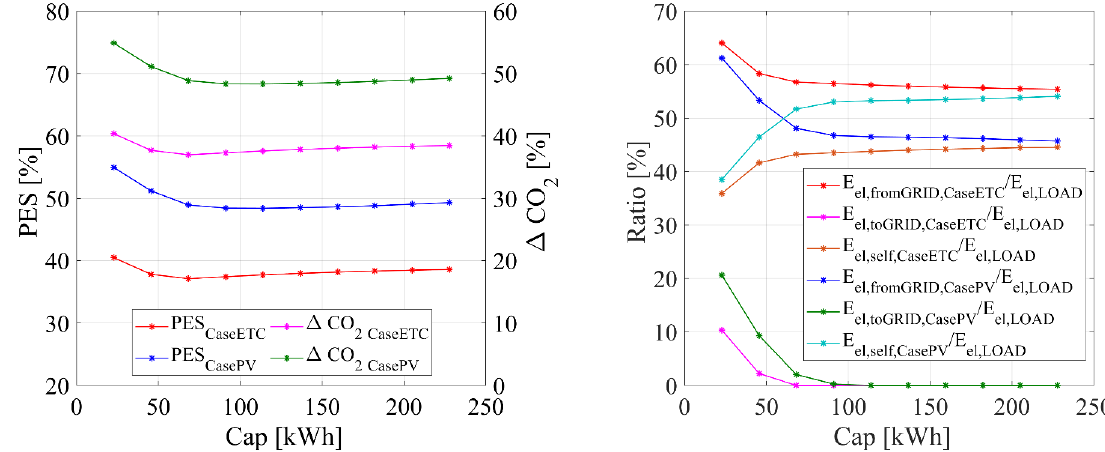
Figure 10. Parametric analysis: PES and ∆ CO 2 ( left ) and energy ratios ( right ).